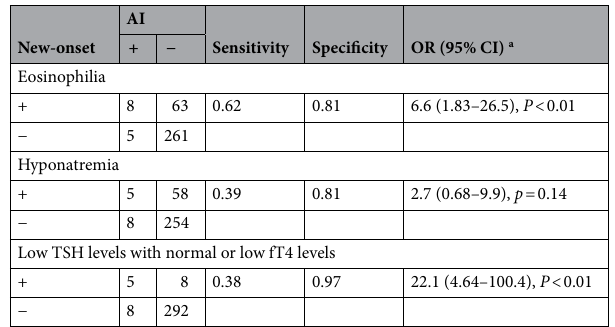
Table 4. Detailed clinical profiles of the patients with ICI-induced secondary AI. OR: odds ratio, CI: confidence interval. a Fisher’s exact tests were performed to compare the incidence of secondary AI.